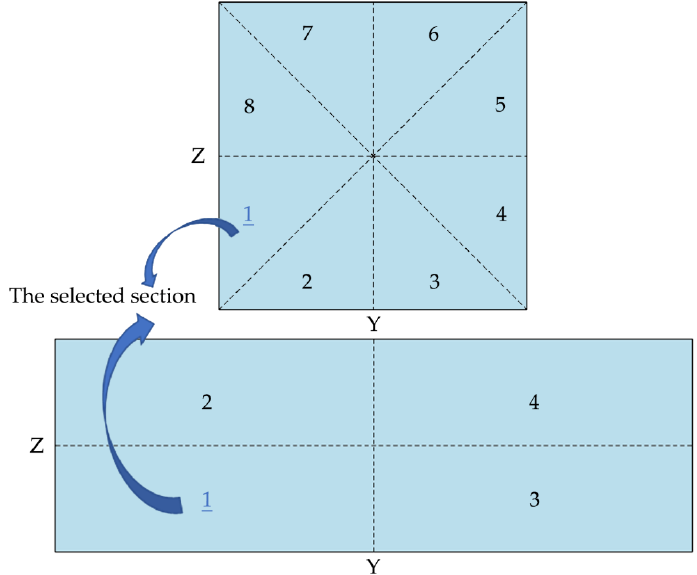
Figure 4. Schematic diagram of the selected simulated section on the cross-section.